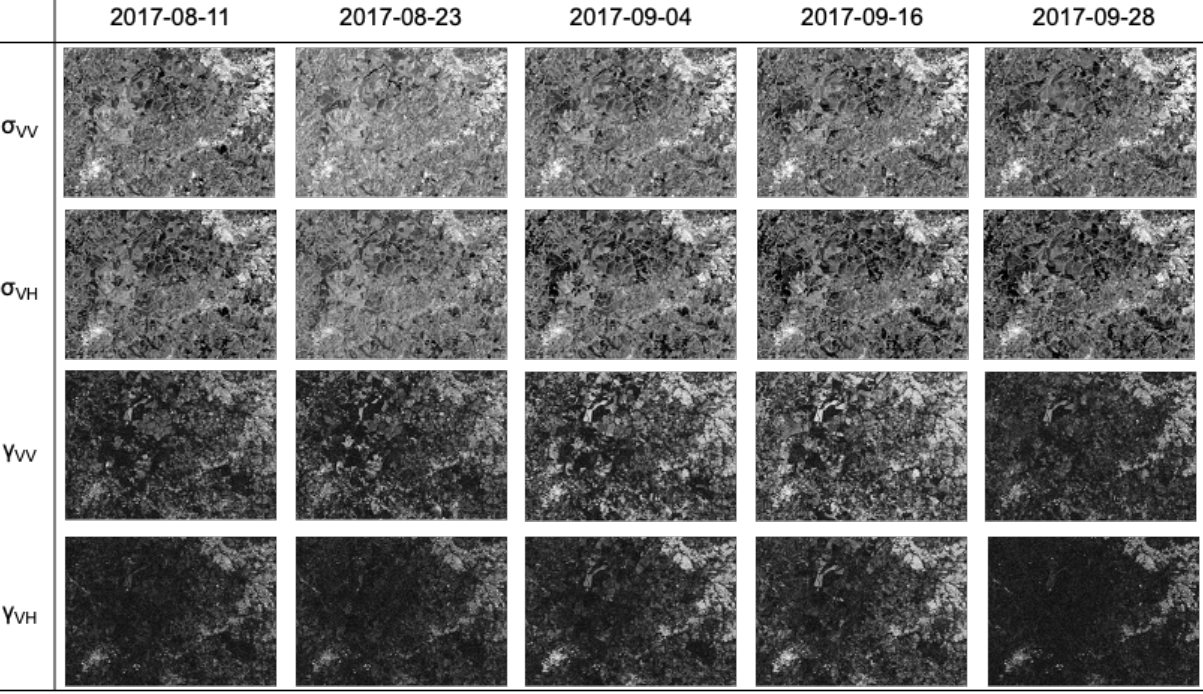
Figure 12. Images of coherence and intensities in the two winter months of August and September for both polarization. The coherence colors range from 0 (black) to 1 (white). The intensity values are shown in decibels. For the VV channel, the color range is set between − 15 and − 5 and for the VH channel it is set between − 20 and − 10. In all the images, lighter colors indicate higher